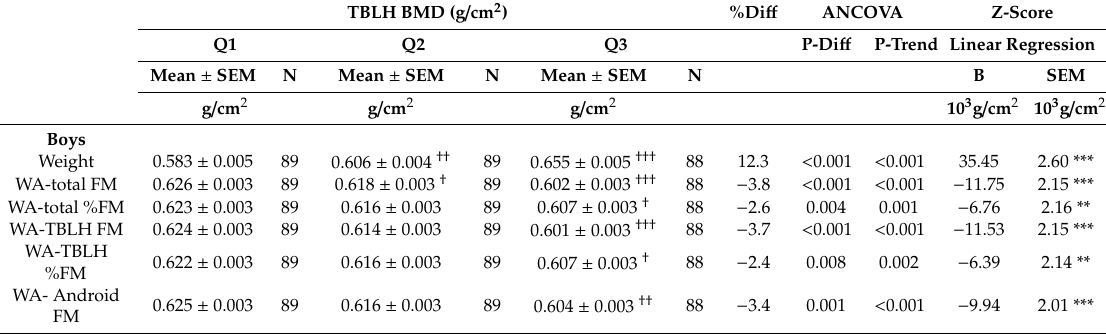
Table 2. Covariate-adjusted mean (SEM) TBLH BMD by tertiles of each WA-index of